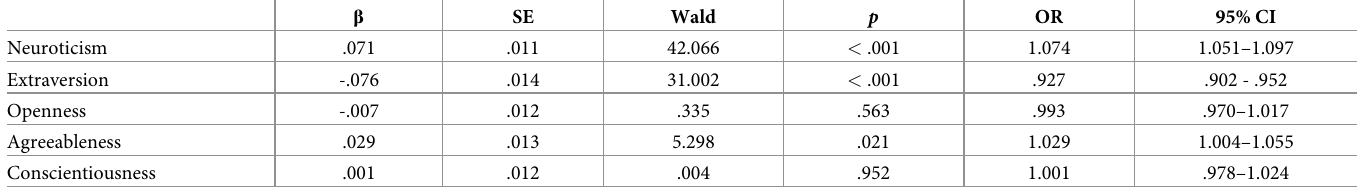
Table 2. Logistic regression analysis of Revised NEO Personality Inventory personality predictors of diagnostic group, i.e. social anxiety disorder or healthy control.